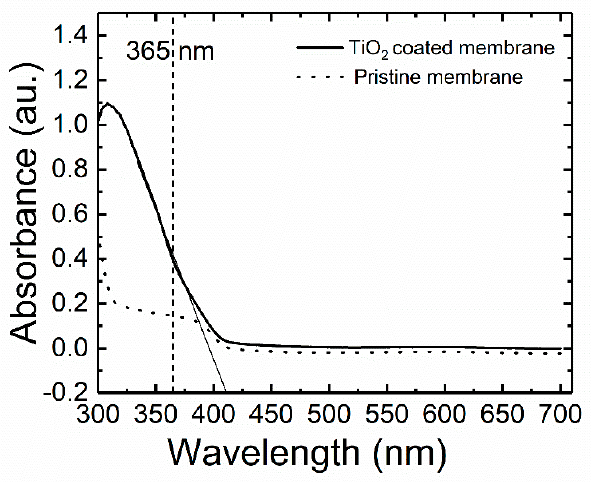
Figure 4. Light absorption of TiO 2 -coated membranes and pristine membrane in quartz cuvette filled with MilliQ water inside the integrating sphere.